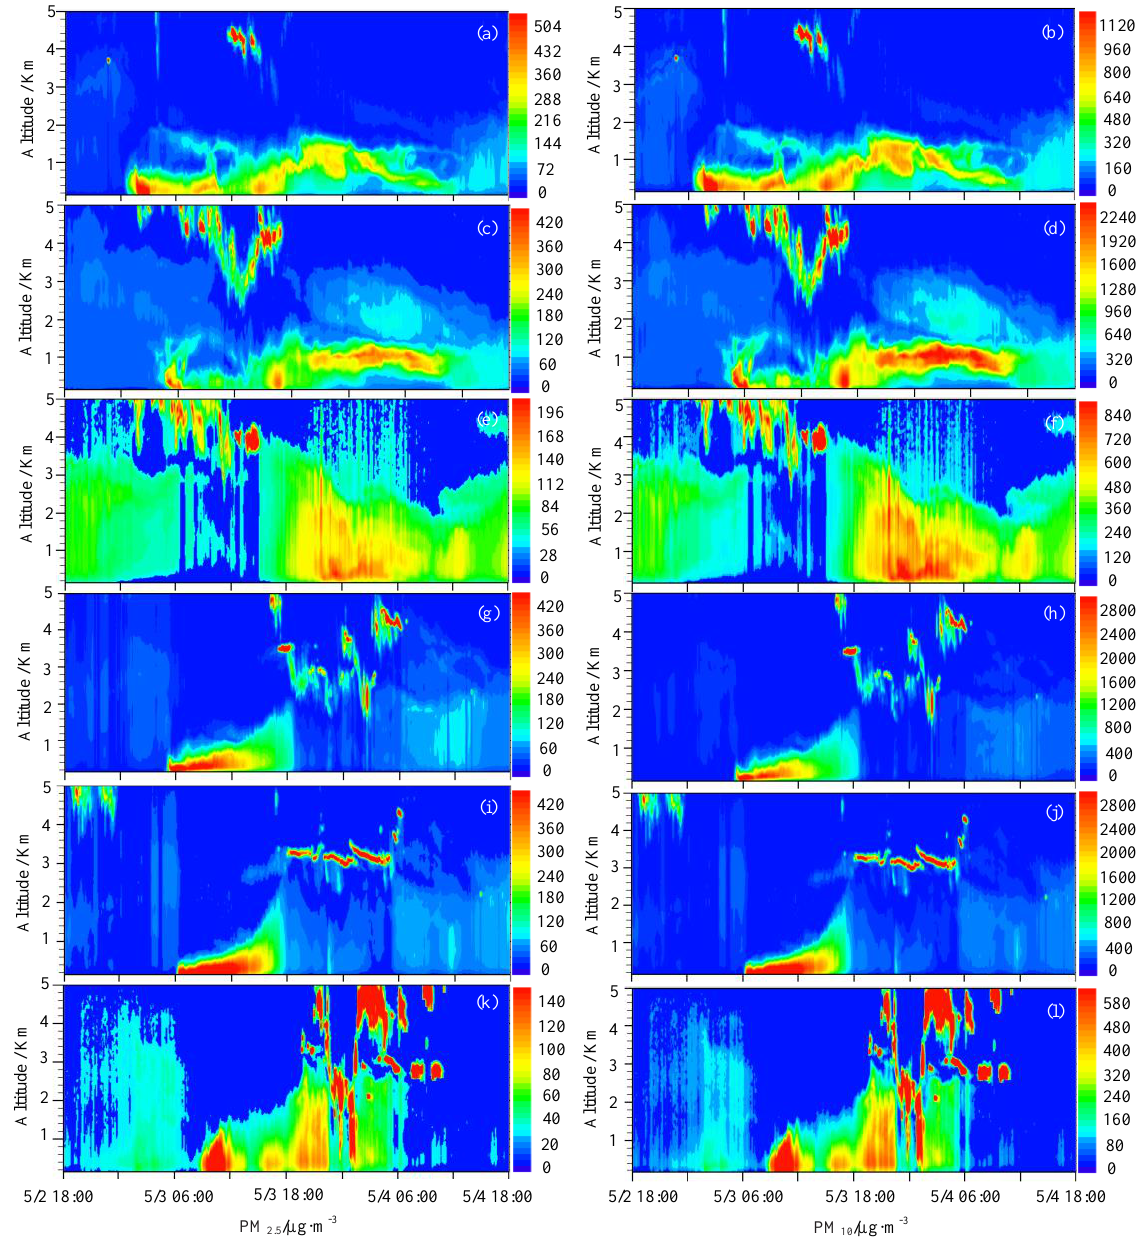
Figure 8. Hourly concentration of PM 2.5 , PM 10 at vertical fitted by the formula in Table 3 (from top to bottom: Jiayuguan ( a ), ( b ), Yumen ( c ), ( d ), Aksay ( e ), ( f ), Jinchang ( g ), ( h ), Wuwei ( i ), ( j ), Baiyin ( k ), ( l )).